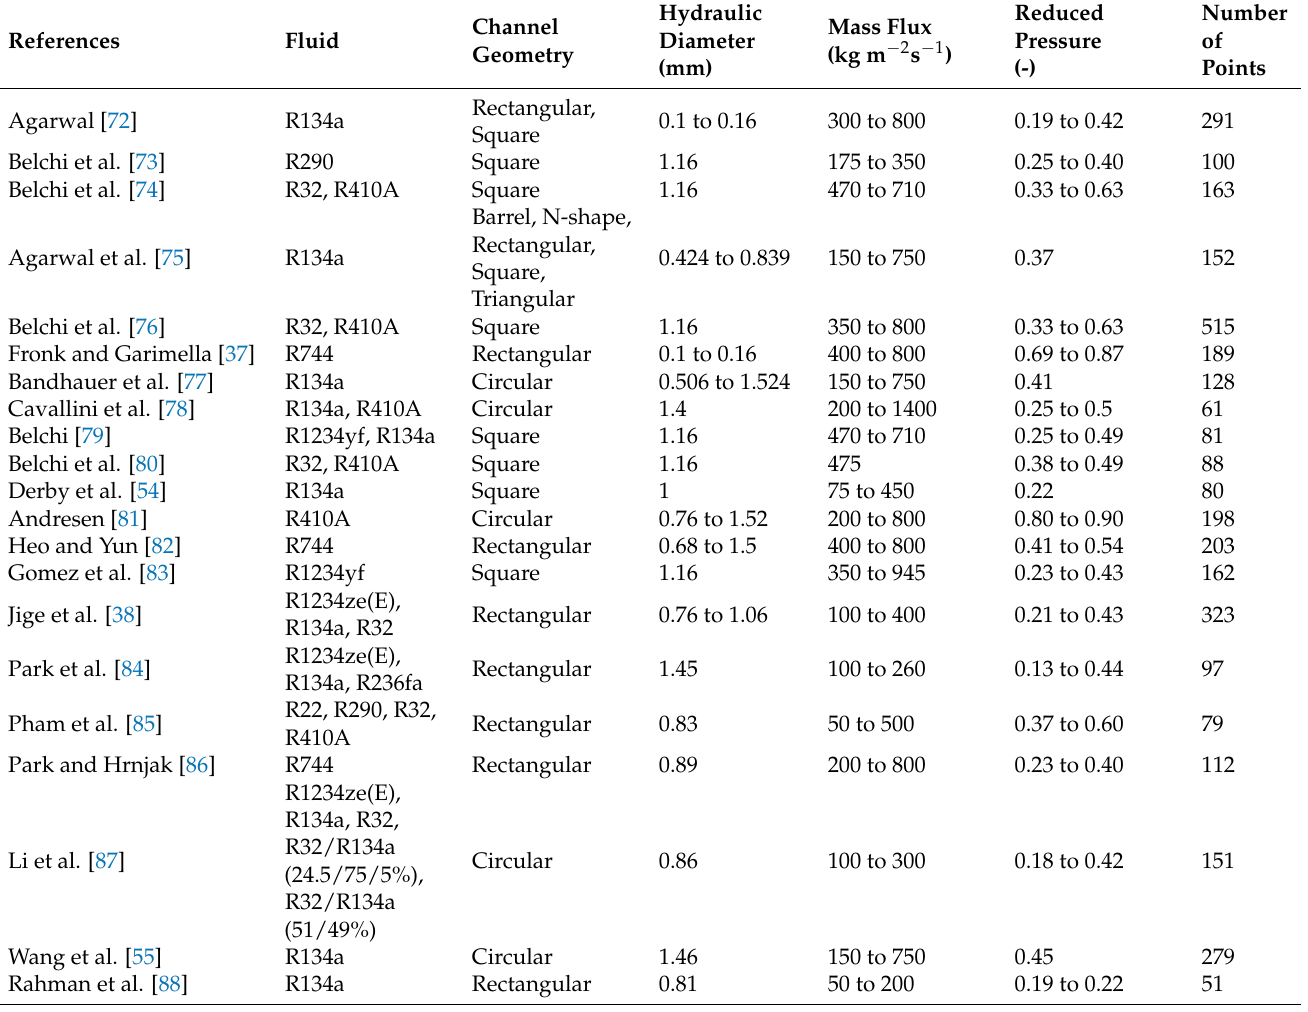
Table 1. The database sources for the HTC in multi-port